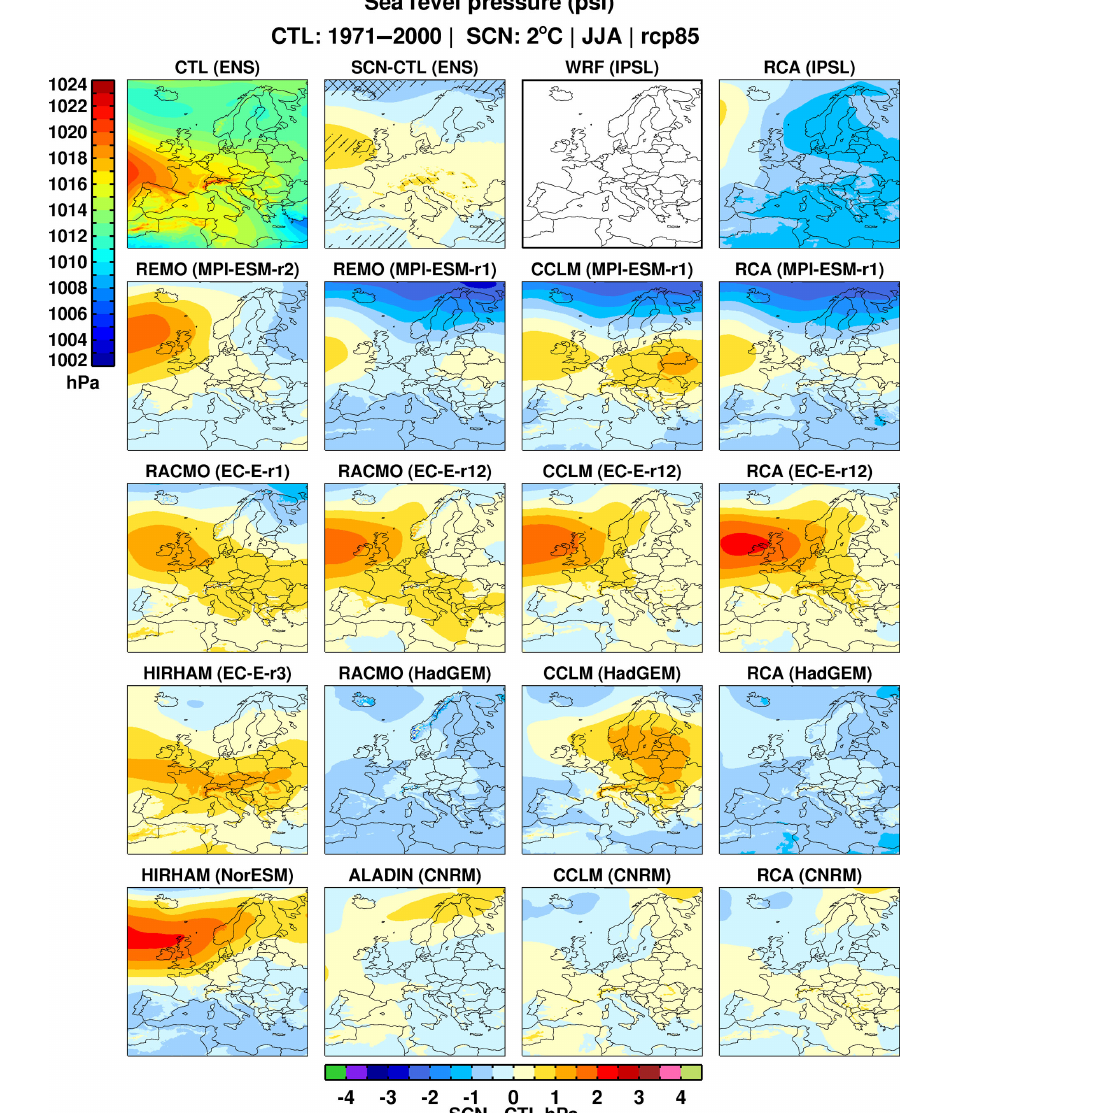
Figure 3. Summer (JJA) mean sea level pressure in the reference period (ensemble mean in the uppermost left panel) and its change in 17 RCM simulations in Table 1 (individual runs in the upper right panel and all other rows) for the + 2 ◦ C of warming level (SWL2). Hatching in the ensemble mean signal (second upper panel from the left) represents areas where at least 14 of the 18 ensemble members agree on the sign of change. Cross-hatching indicates that there is agreement on the sign of change and that the signal-to-noise ratio is larger than